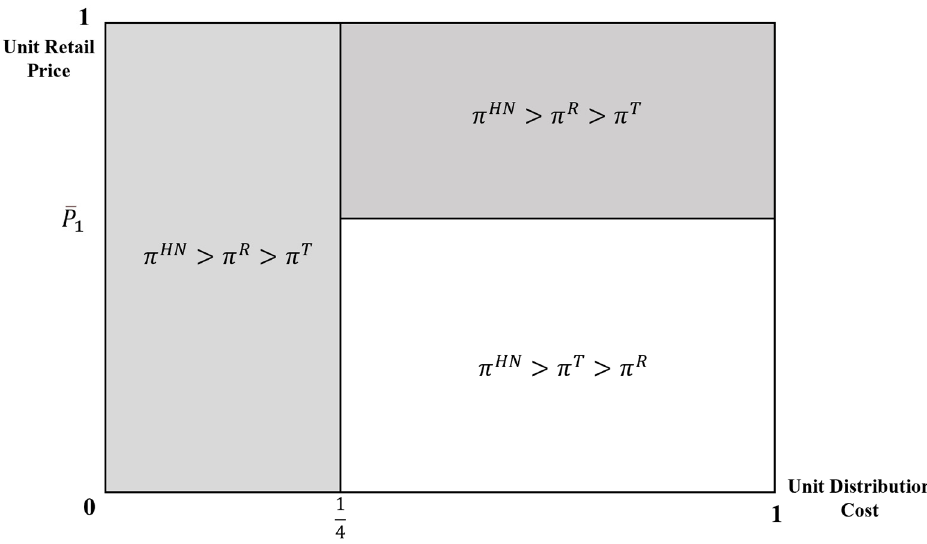
Figure 6. Operating enterprise business model selection path diagram in the complementary case.